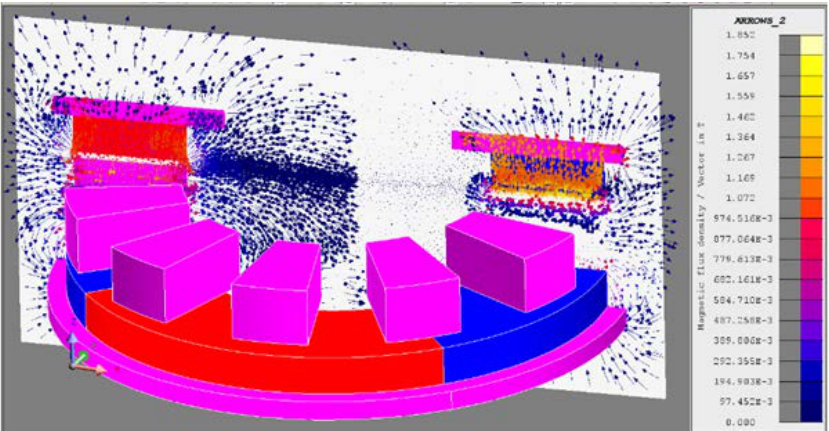
Figure 2. Magnetic field of AFMG (MG 2 : 2/11/9 G R2 = 5.5).